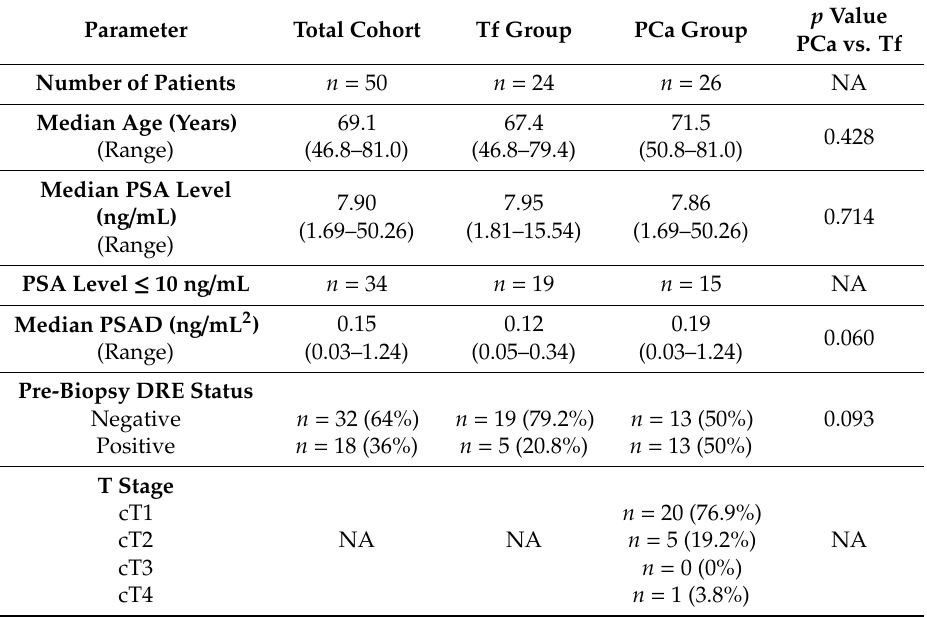
Table 1. Demographic and clinico-pathological characteristics of patients included in the